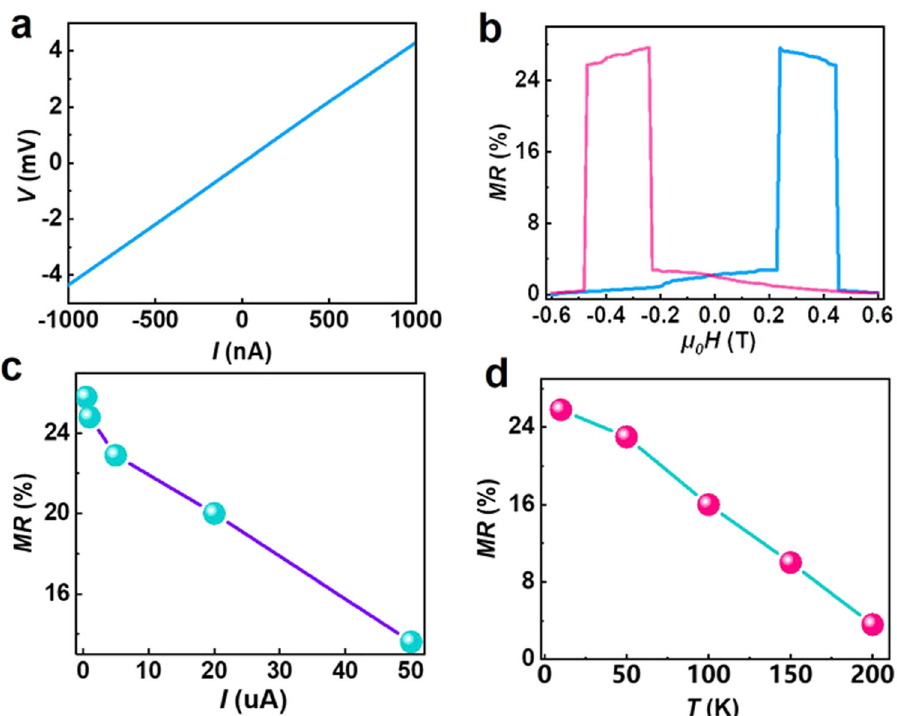
Fig. 3 Charge and spin transport behaviors of FGT/WSe 2 /FGT with 6.9 nm WSe 2 spacer. a The current – voltage curve of FGT/WSe 2 (6.9 nm)/ FGT spin valve at 10 K. b MR of the FGT/WSe 2 /FGT spin valve with I = 10 nA at 10 K. c MR of FGT/WSe 2 /FGT with different bias currents. d MR of FGT/WSe 2 /FGT spin valve at different